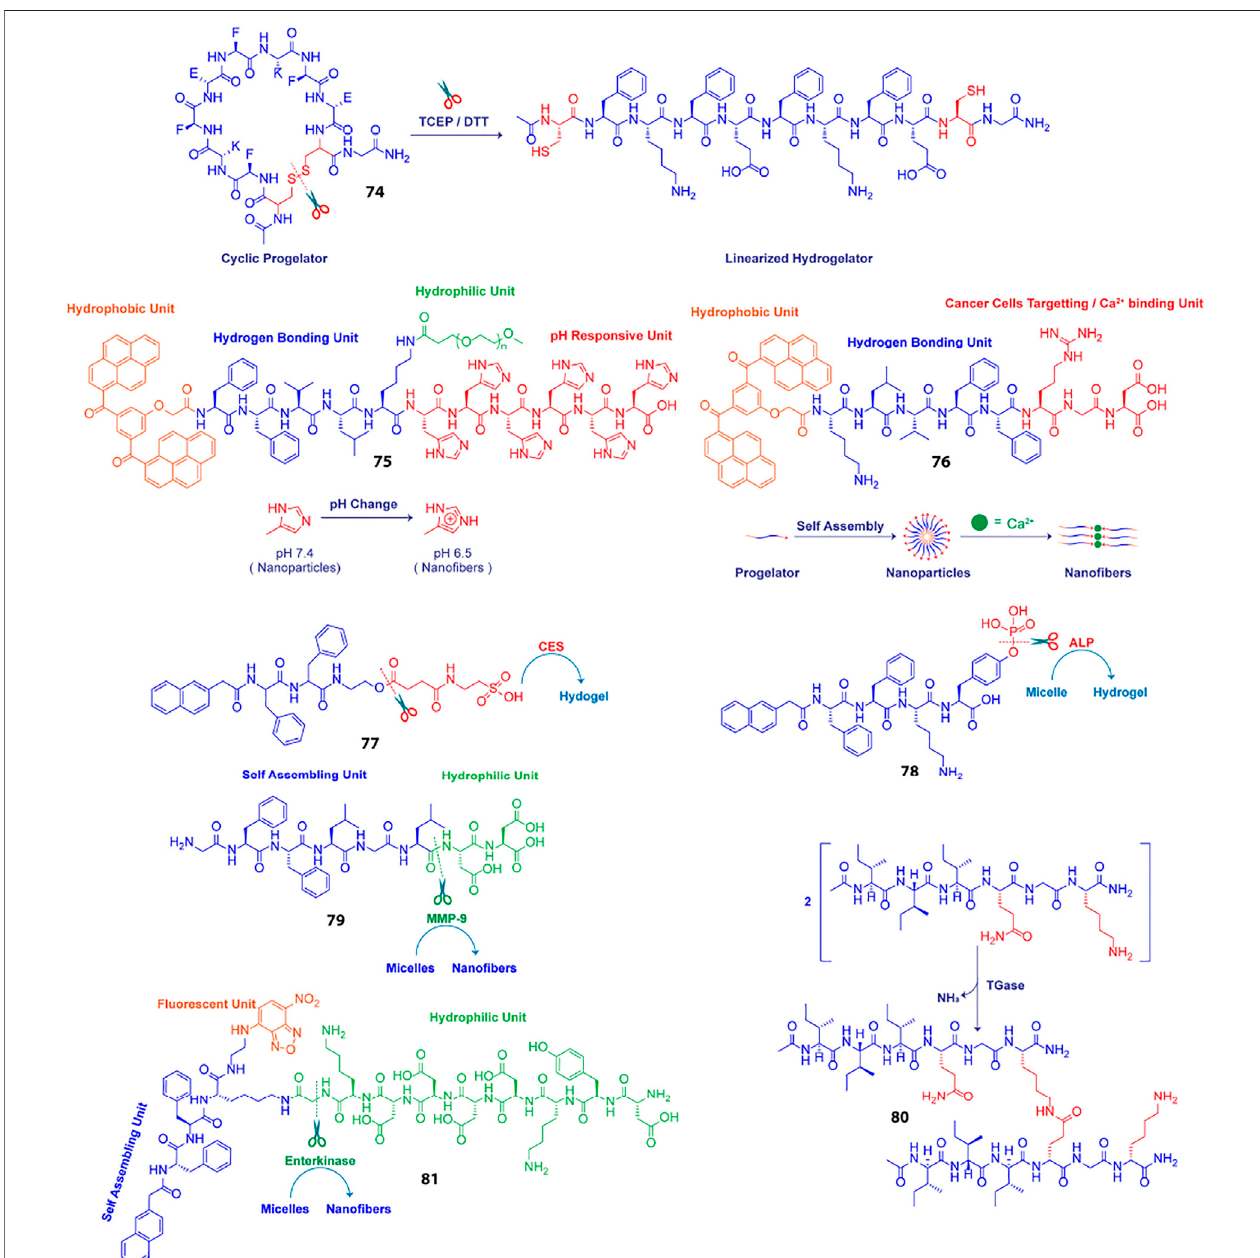
Scheme 4 | Schematic presentation of different chemically and enzymatically induced in-situ hydrogelation processes.